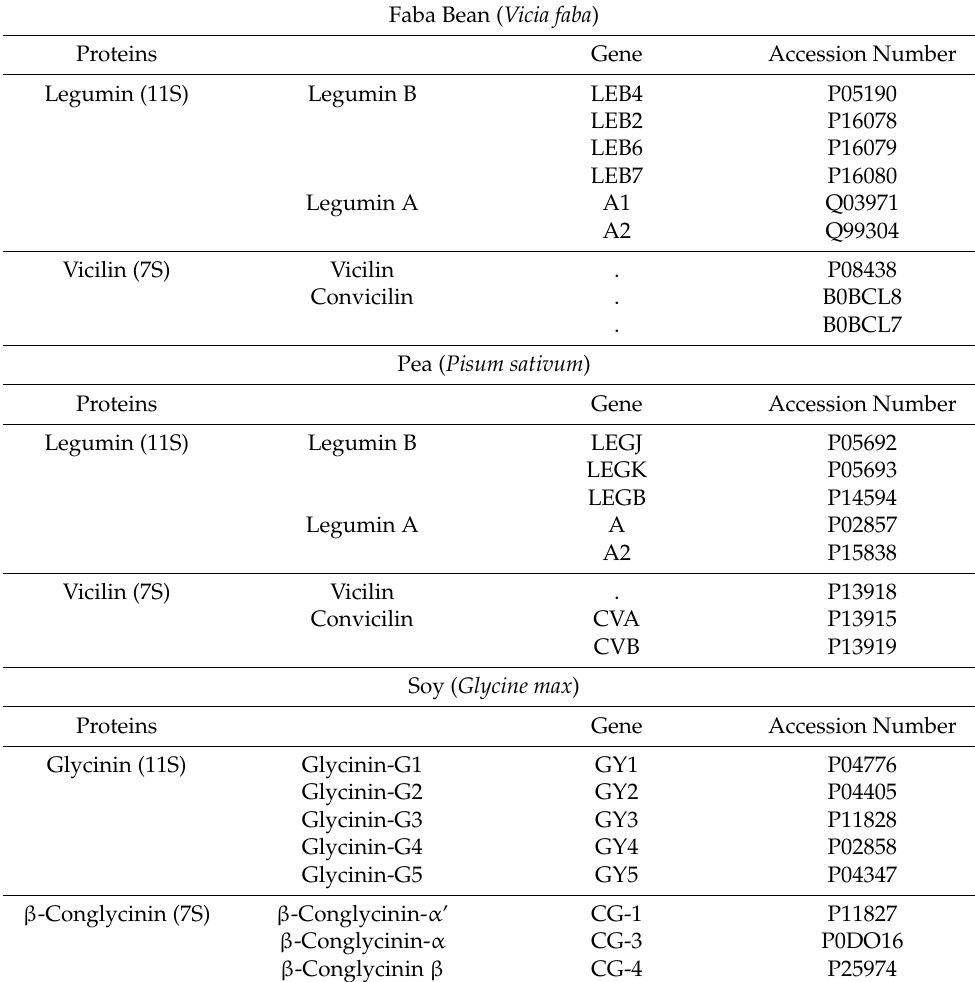
Table 6. UniProtKB Protein accession numbers of faba bean, pea and soy main storage proteins used for the in silico